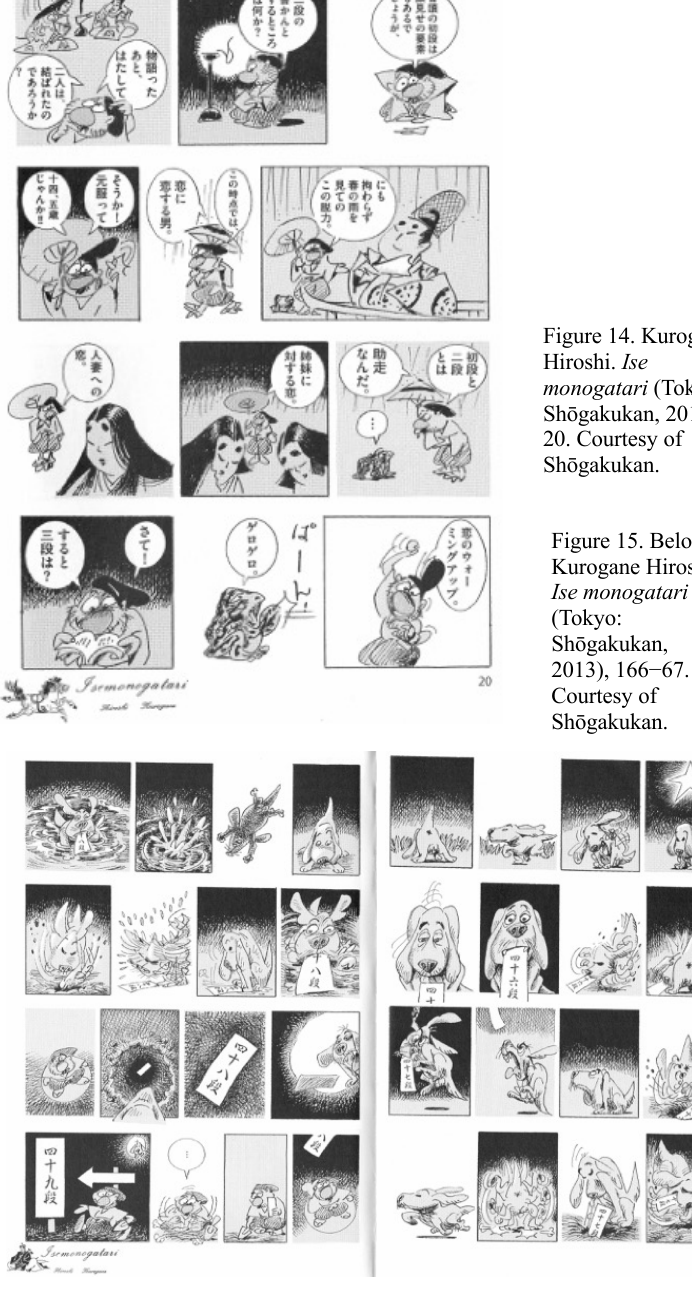
Figure 14. Kurogane Hiroshi. Ise monogatari (Tokyo: 20. Courtesy of